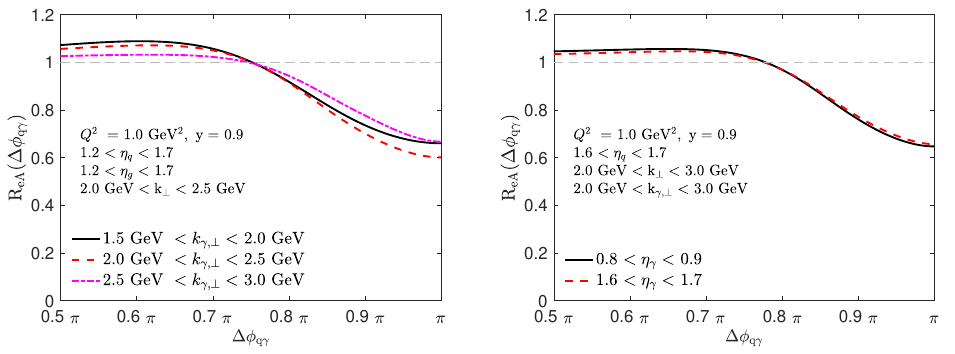
Figure 5 . Left: R eA computed for different ranges in the photon transverse momentum. Right: R eA for different ranges in the photon